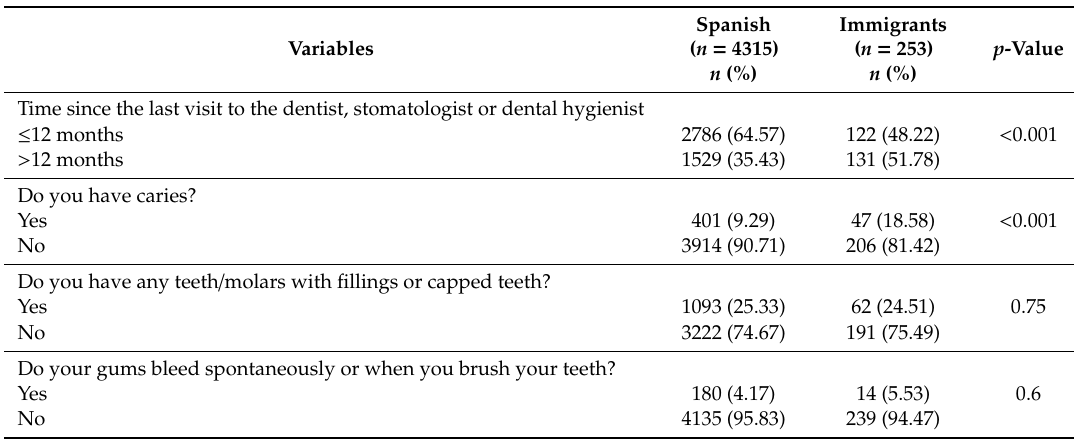
Table 1. Utilization of dental health services and oral health problems in the Spanish and immigrant child-adolescent population. Spanish National Health Survey, 2017.